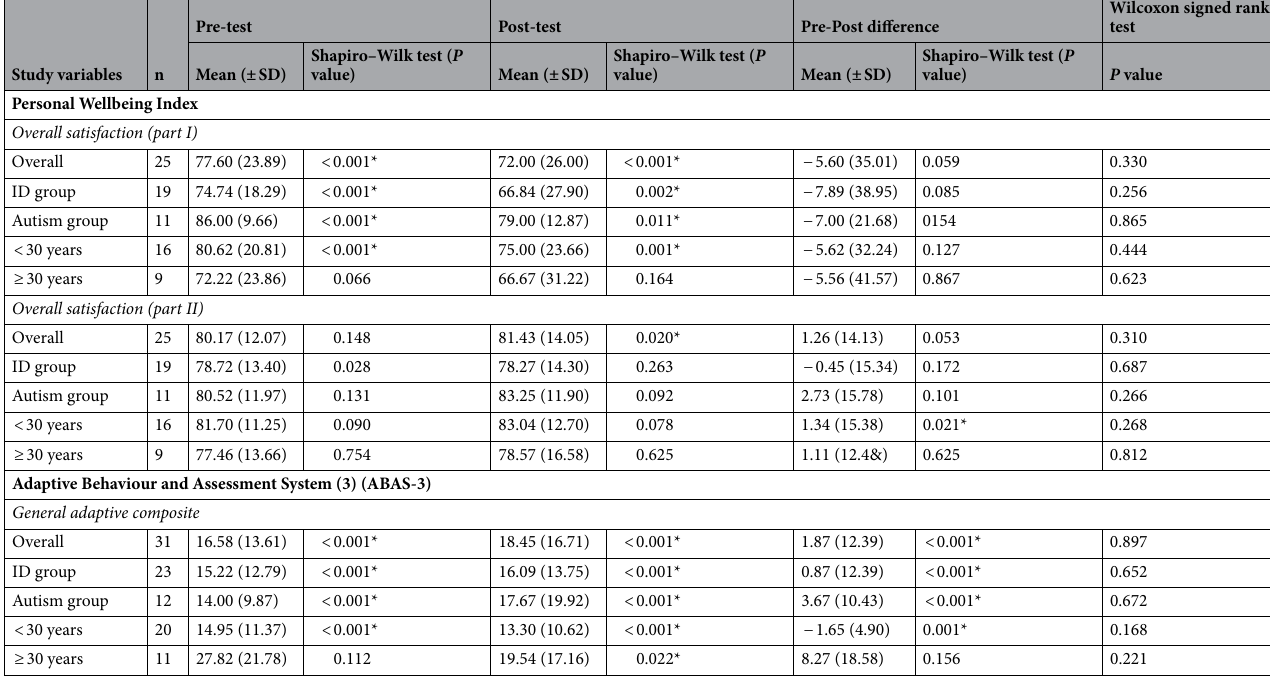
Table 3. Pre-post statistical analysis of Personal Well-Being (PWI) and Adaptive Behaviour and Assessment System (3) (ABAS-3) with Wilcoxon Signed Ranks test. Shapiro–Wilk was used for normality check. ID intellectual disability. Asterisk indicatesstatistical significance.